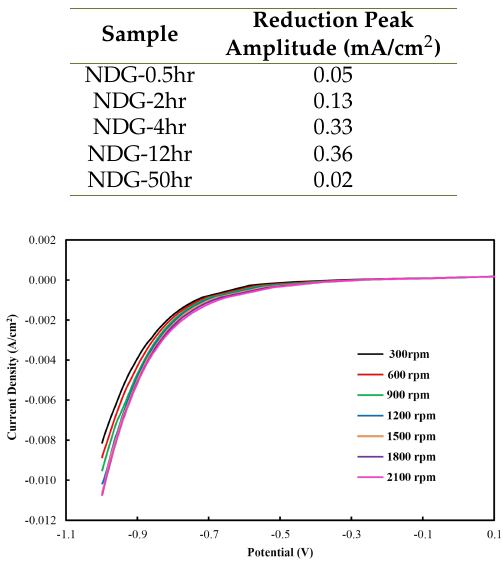
Table 2. Reduction peak amplitude of all samples.